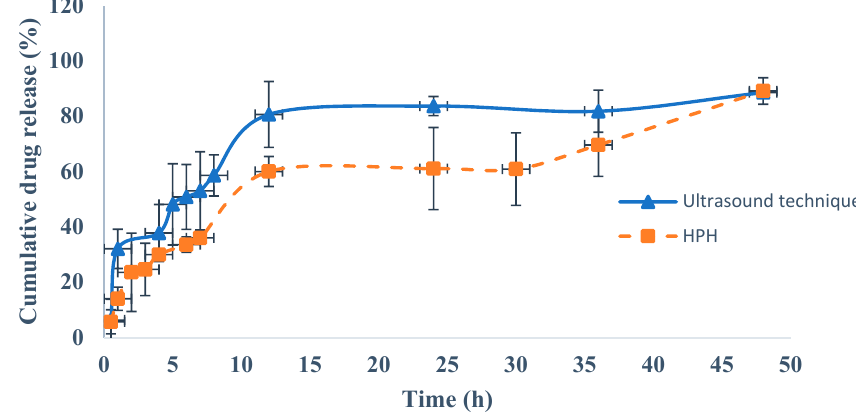
Figure 4. Cumulative percentage of drug release in phosphate-buffered solution (pH 6.4) from rivastigmine-loaded nanostructured lipid carriers (NLC) produced by ultrasound technique and rivastigmine-loaded NLC produced by high-pressure homogenization (HPH) method.